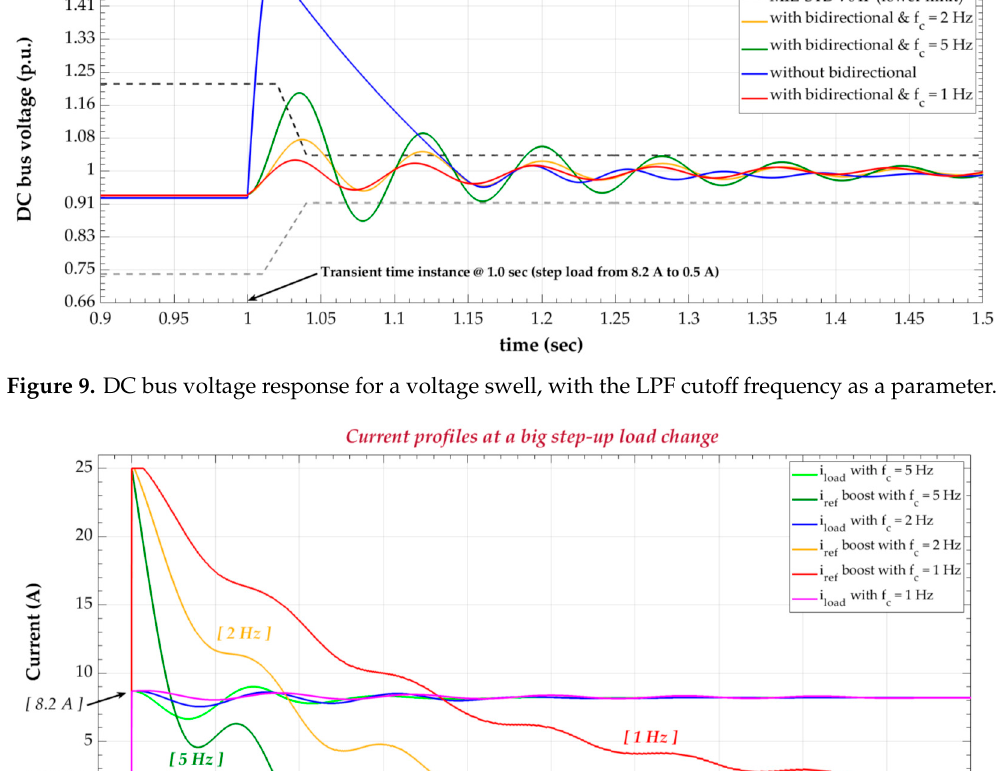
Figure 11. Inductor current reference for a voltage swell case, with LPF cutoff frequency as a parameter. The inductor current (as well as the total converter current reference) is inversely proportional to the LPF cutoff frequency, implying that a cutoff frequency of f c = 1 Hz will force the BBBC to operate for a longer duration, as such providing more energy to the DC bus, with respect to the f c = 2 Hz and f c = 5 Hz, accordingly. Hence, the lower the LPF cutoff frequency, the higher the total energy losses of the system are, as it is presented in Figure 12. In more detail, the total amount of energy losses is approximately 5 J, for the case of f c = 1 Hz, whereas this amount is decreased by 54.7% and by 82.4%, for the cases of f c = 2 Hz and f c = 5 Hz, respectively. In parallel, both the inductor and semiconductor switches losses play a major role to the total amount of the system power losses, with a percentage of approximately 50% for the inductor and 46% for the MOSFETs power losses, while the rest (4%) portion, corresponds to the supercapacitor bank conduction losses. It is worth noting that the energy losses have been calculated in boost mode of operation of the BBBC (voltage sag case), considering the analysis presented in Section 3.4, in respect to the datasheet parameters [28], without the addition of compensation ramp (worst-case scenario). The estimated efficiency of the system in boost operation (voltage sag case) as a function of the BBBC output current is depicted in Figure 13.